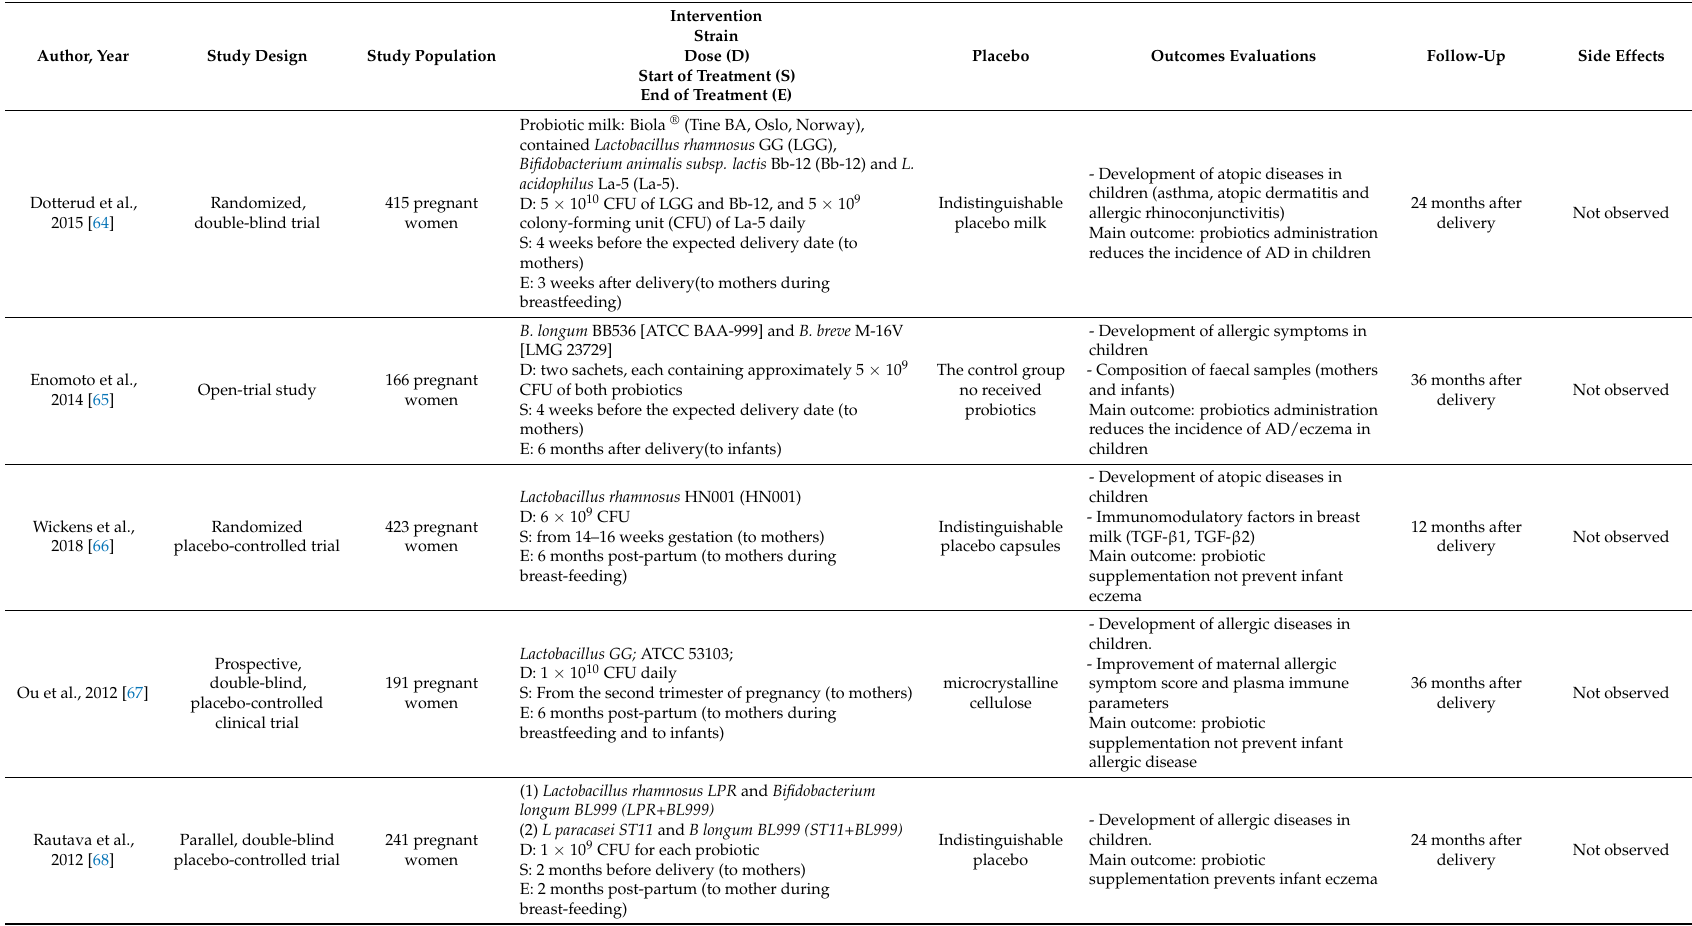
Table 2. Probiotics administration during pregnancy and after delivery in prevention of allergic